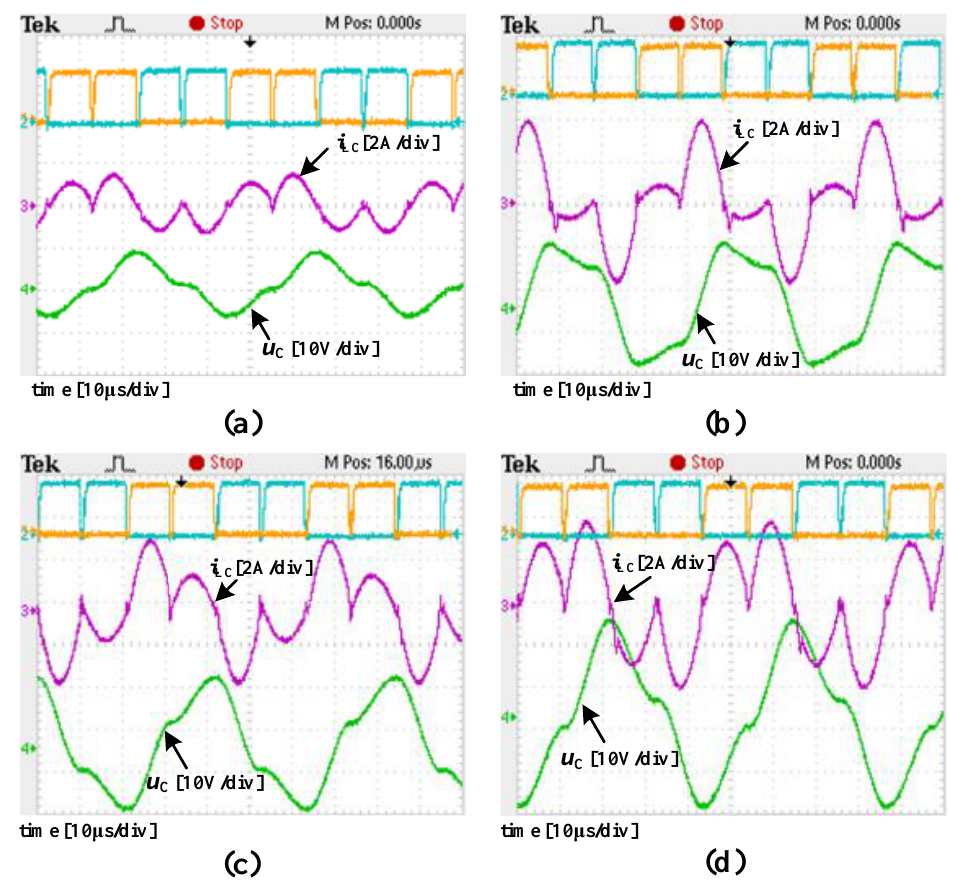
Figure 9. Experimental waveforms of the proposed FBBRLCC in different operation modes. ( a ) 1-1